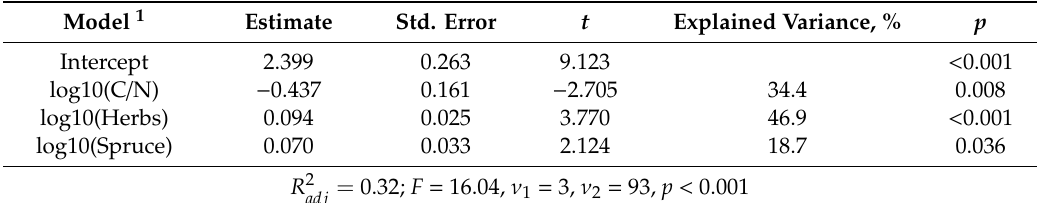
Table 2. Results of regression analysis for carbon stock in the mineral layer 0–50 cm.